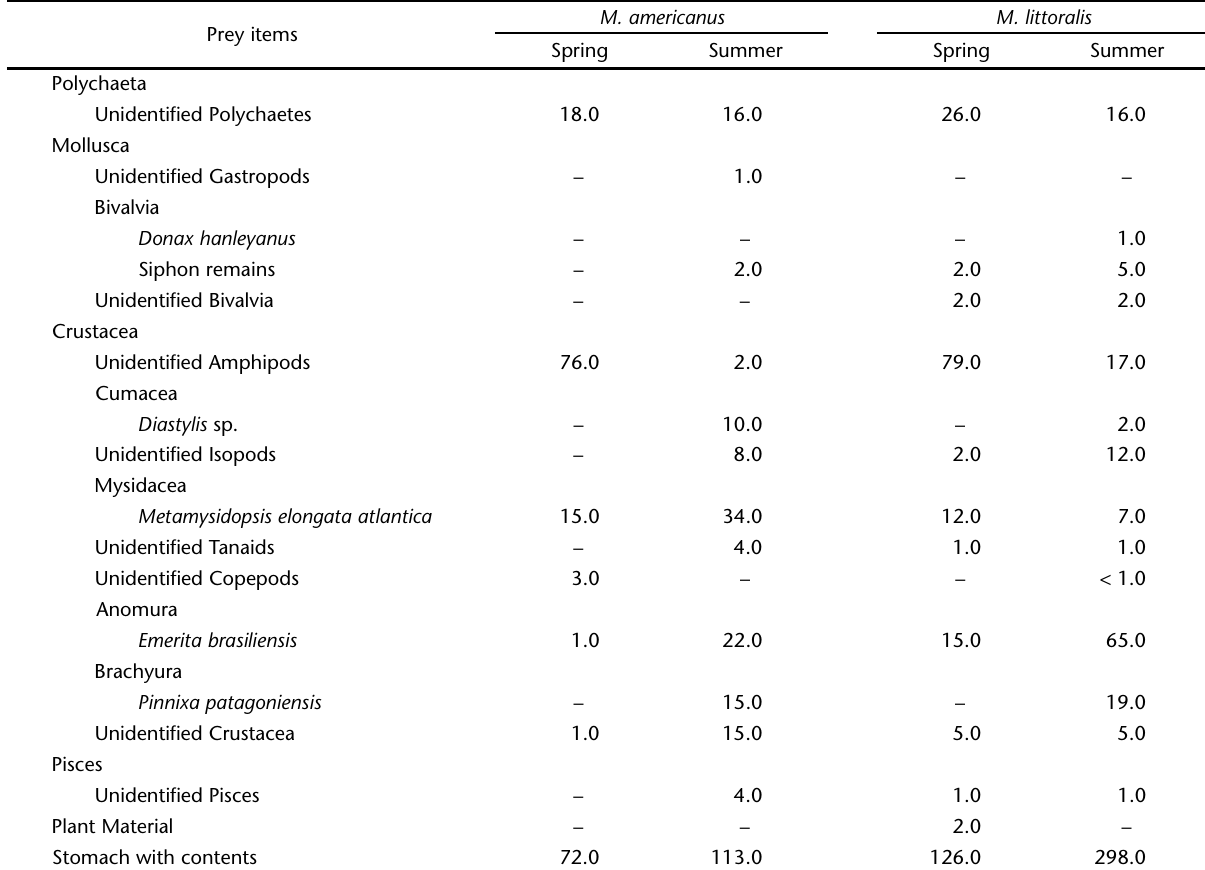
Table I. Frequency of occurrence (%FO) of items present in the diet of M. americanus and M. littoralis during Spring and